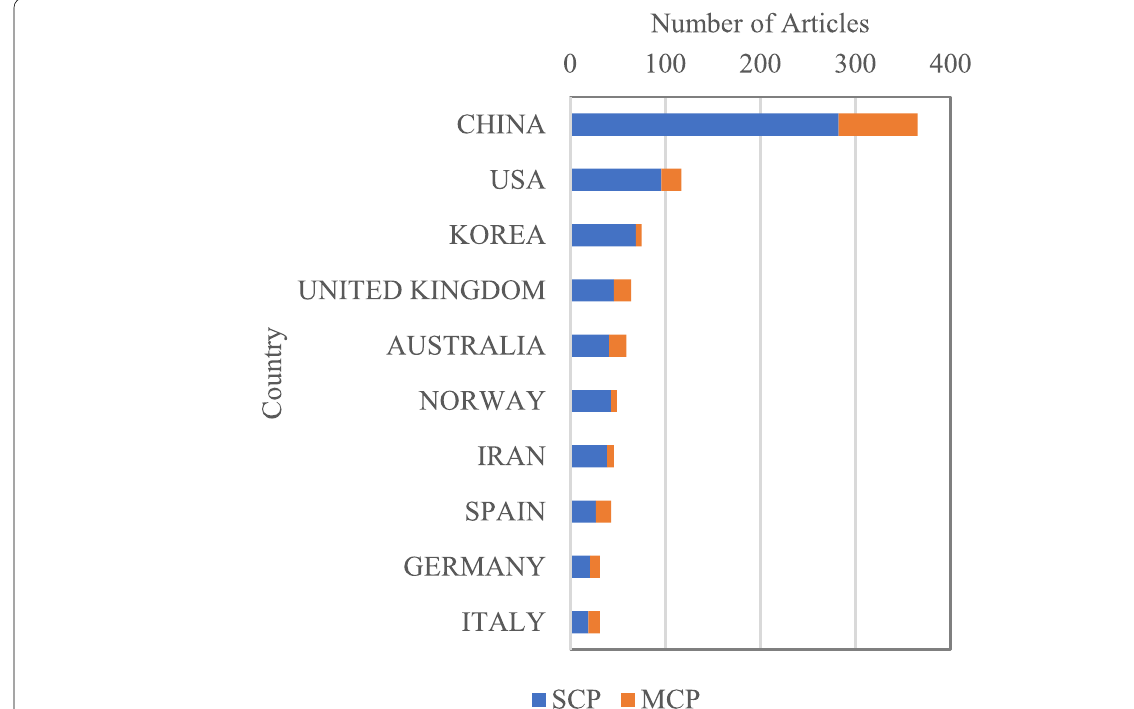
Fig. 19 Absorbent, top contributing countries